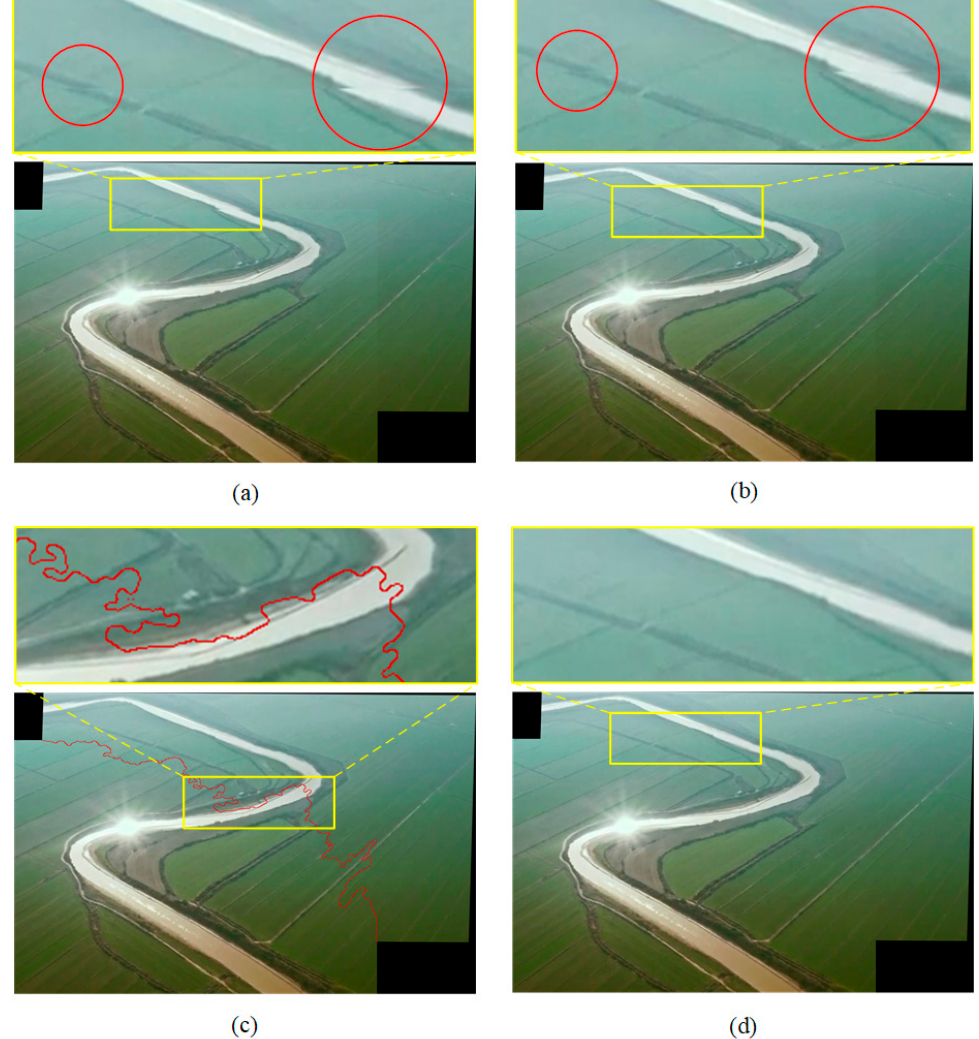
Figure 4. Mosaic images obtained from different methods. ( a ) Directly seamed at image boundaries; ( b ) directly seamed with multi-band blending; ( c ) detected stitching line; ( d ) stitch result of proposed method.